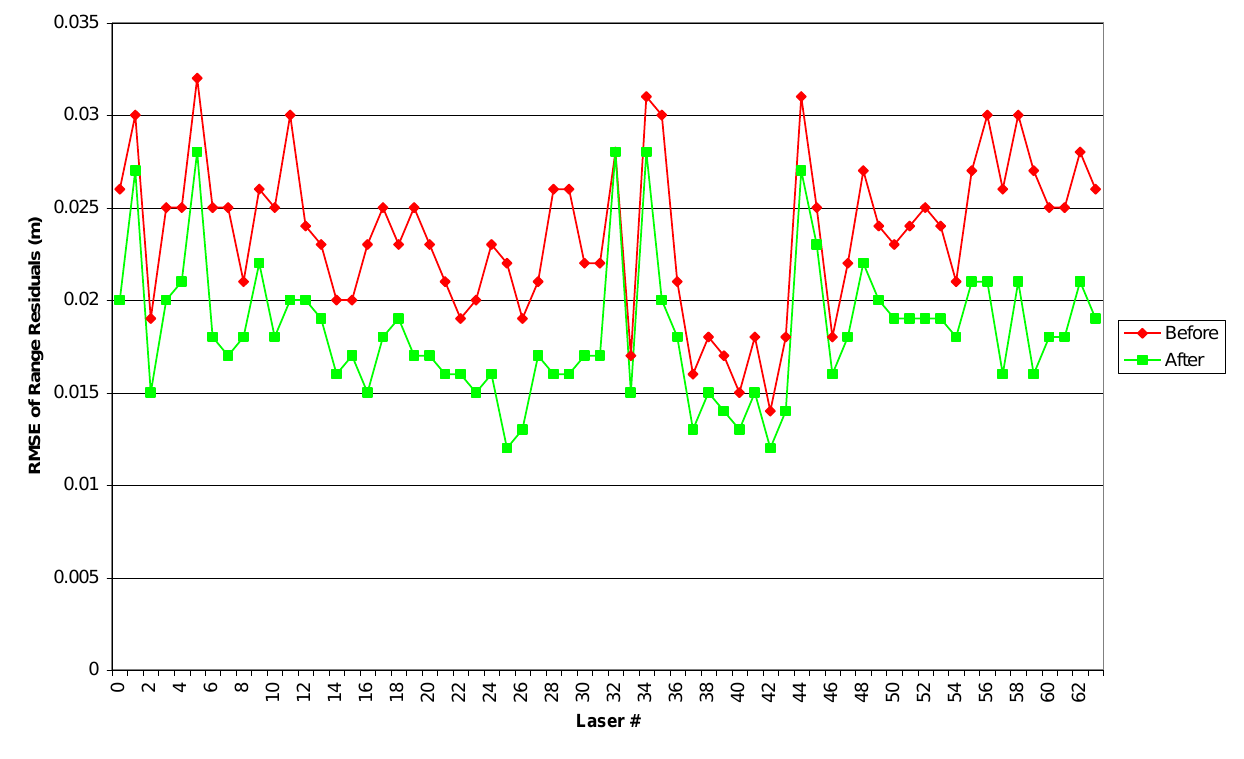
Figure 7. RMSE of Range Residuals for Each Laser, Before and After Adjustment, Laser 2–Set 1. RMSE of Range Residuals By Laser, Before and After